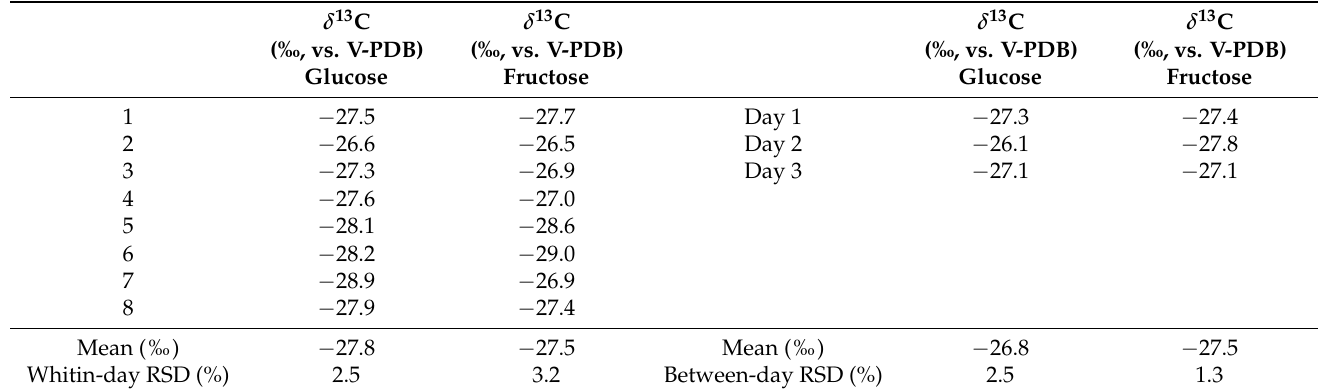
Table 1. Within-day repeatability and between-day repeatability of the method. The mean δ 13 C for glucose and fructose are reported together with the RSD (%). The 13 C/ 12 C values are expressed in the delta scale ( δ ‰), against the international standards V-PDB (Vienna-Pee Dee Belemnite).